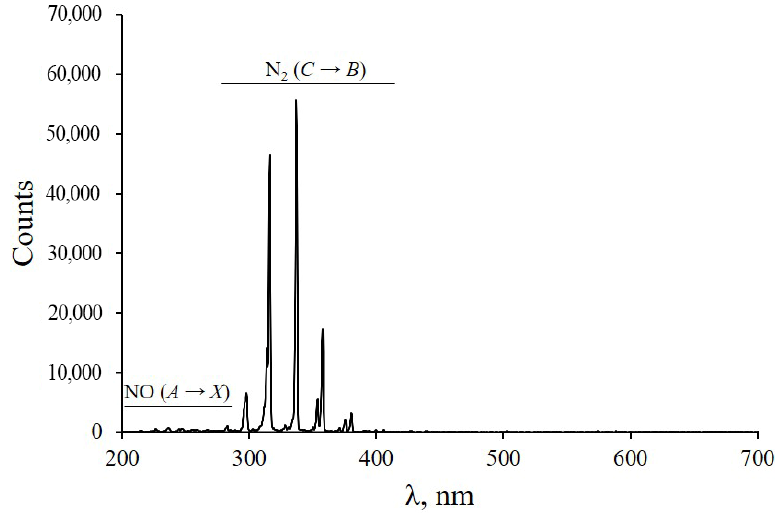
Figure 5. Emission spectrum of DBD CAP in air during branch cut treatment.